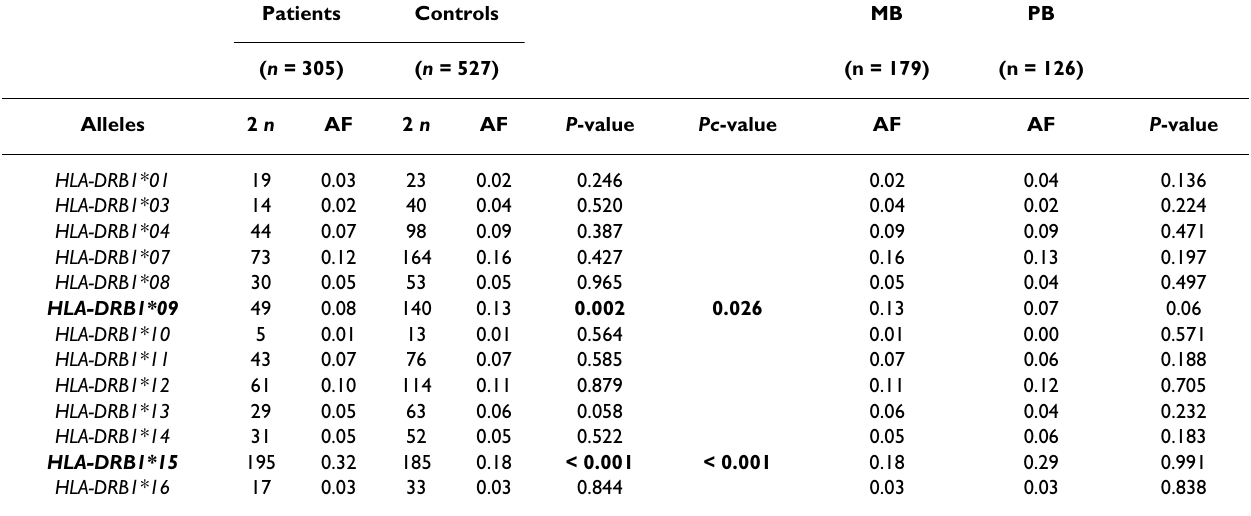
Table 2: Allele frequency distribution of HLA-DRB1* in patients versus controls, and MB versus PB forms of leprosy